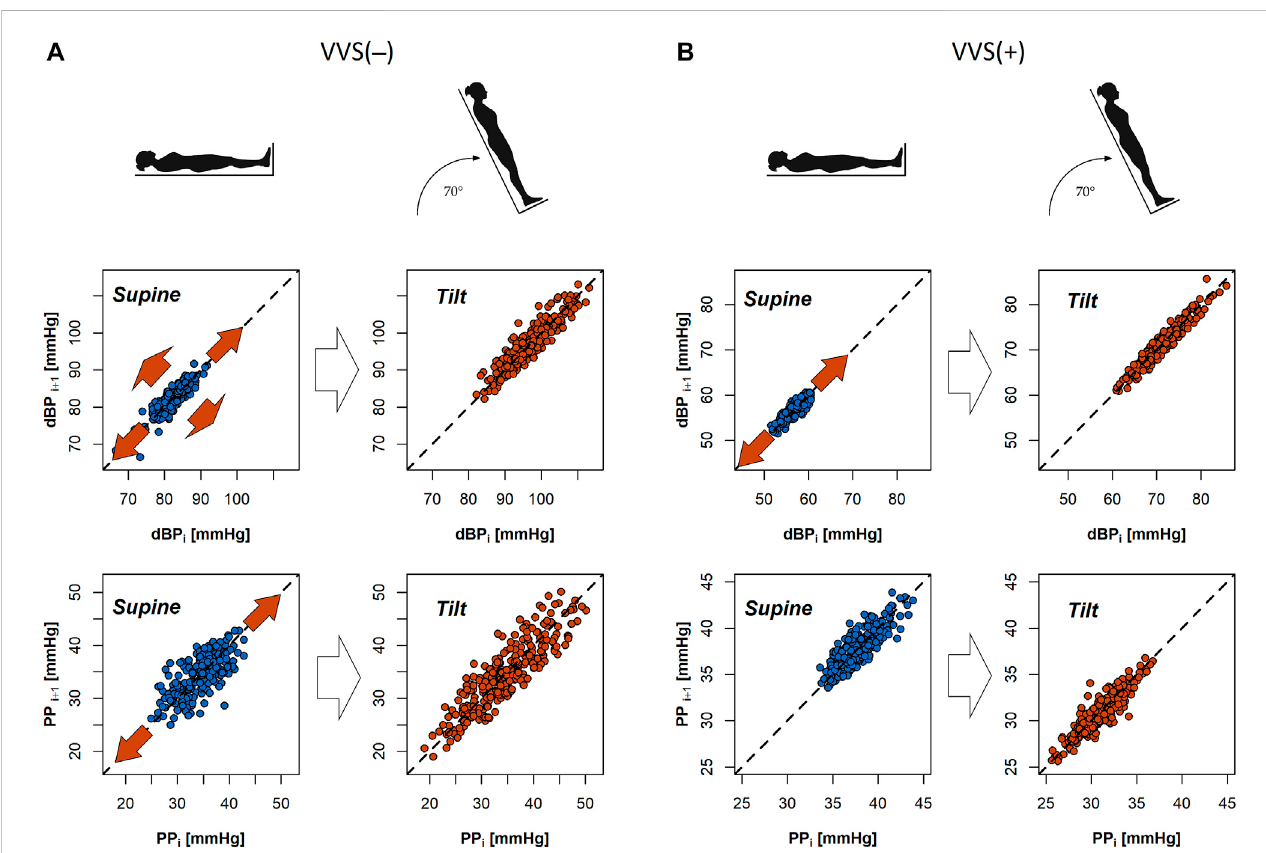
FIGURE 3 Poincaré plots of diastolic blood pressure (dBP) and pulse pressure (PP) biosignals of a subject from the control group (A) and a vasovagal patient (B) during the tilt test. Red arrows in the graphs indicate that the direction of dispersion of points across and alongside the line of identity in the plot (SD1 and SD2 descriptors) changes between the supine and tilt phases.